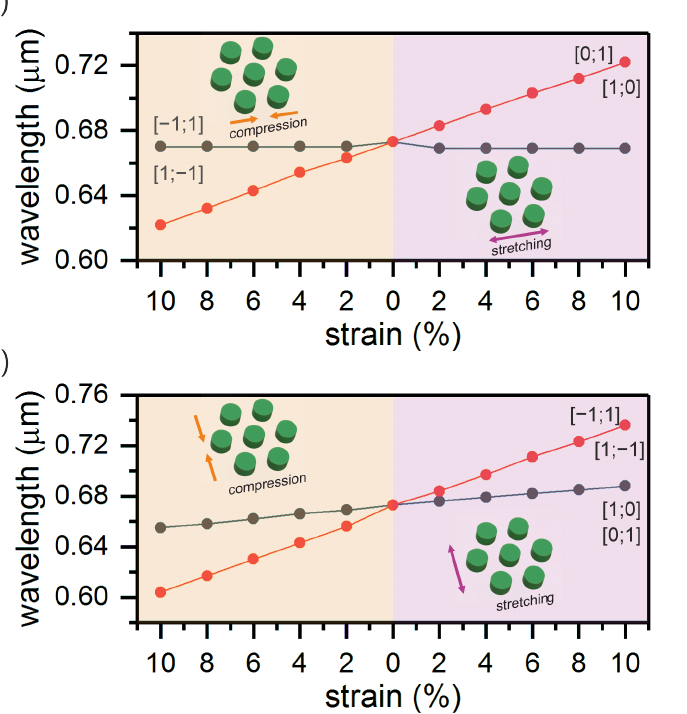
Figure 4. Dependences of the wavelengths of the split peak upon compression or extension of the structure along ( a ) the x and ( b ) y